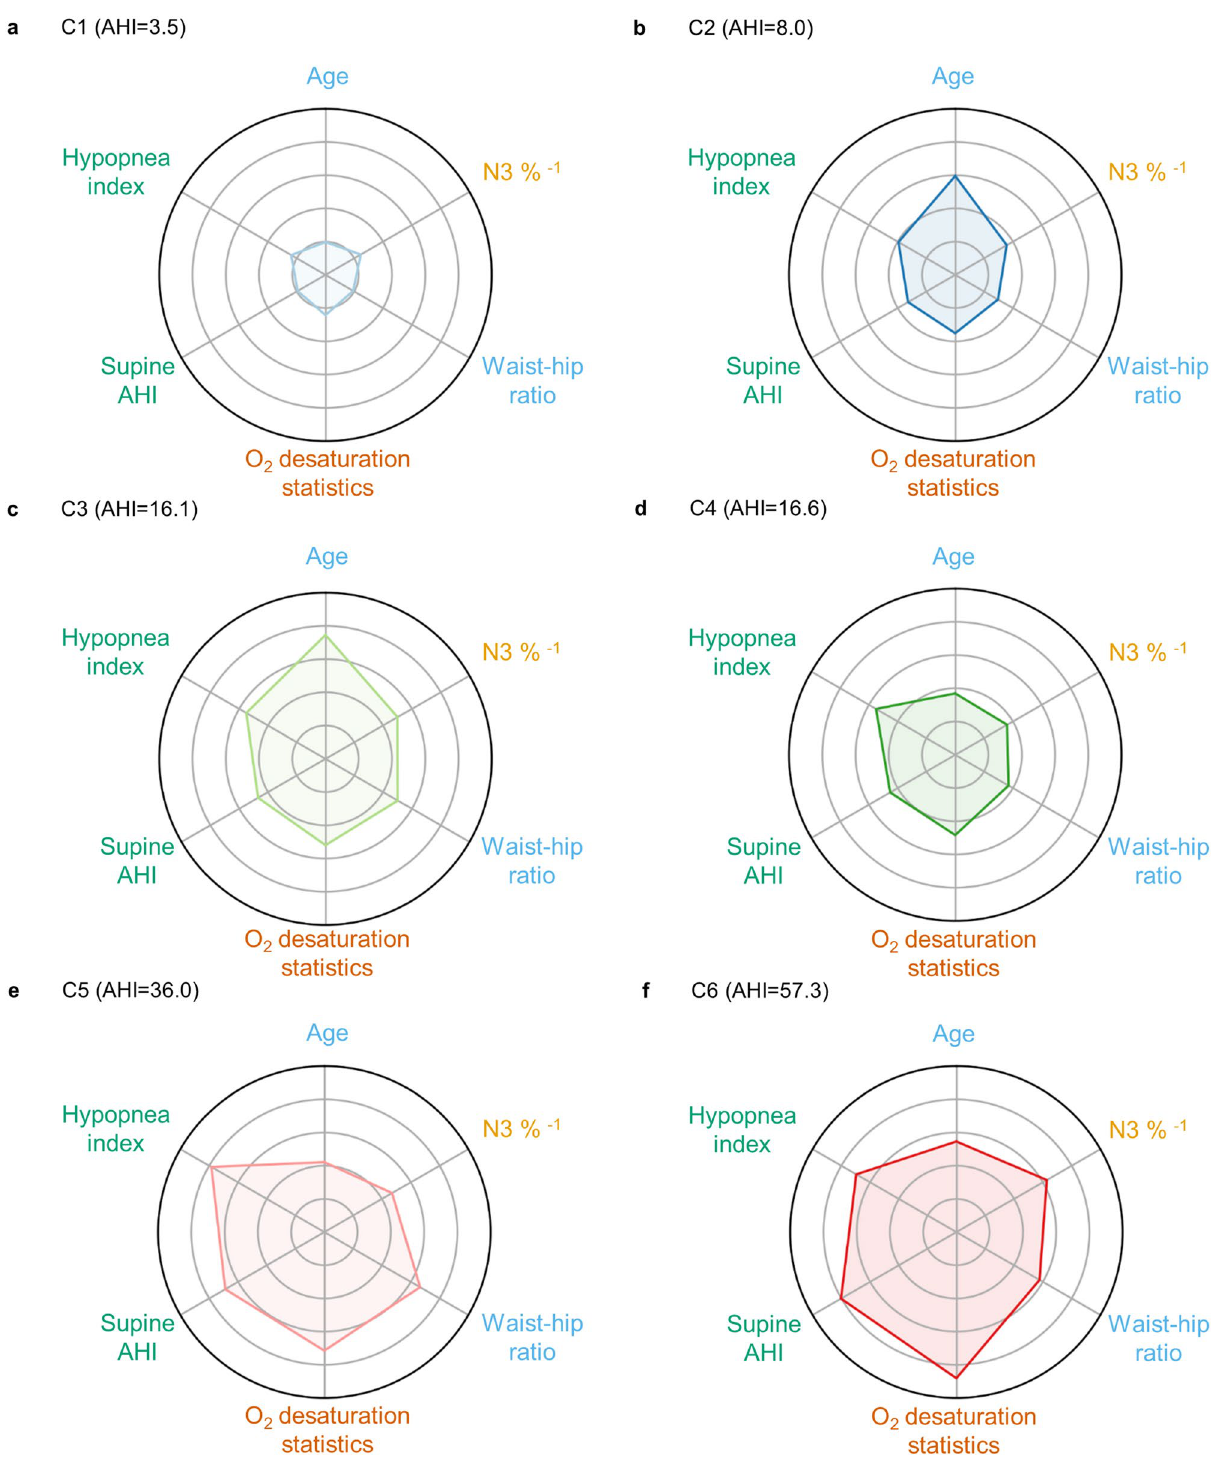
Figure 5. Radar plot of the DPGMM-created clusters with features found important by the RSF. Features with relative importance above 0.1 were chosen as the axes (Fig. 4). The percentile rank of the cluster means with respect to the whole patient data were plotted. Values were inversed for features that were “the-higher- the-better” so that all features were consistently the-lower-the-better. Oxygen desaturation statistics are shown through the mean of the percentiles of the four identified features (sleep time spent under 90% oxygen saturation, average oxygen saturation, oxygen desaturation event index, and lowest oxygen saturation) as these features represent similar clinical information. ( a ) Radar plot of C1 (mean AHI = 3.5), ( b ) radar plot of C2 (mean AHI = 8.0), ( c ) radar plot of C3 (mean AHI = 16.1), ( d ) radar plot of C4 (mean AHI = 16.6), ( e ) radar plot of C5 (mean AHI = 36.0), ( f ) radar plot of C6 (mean AHI =